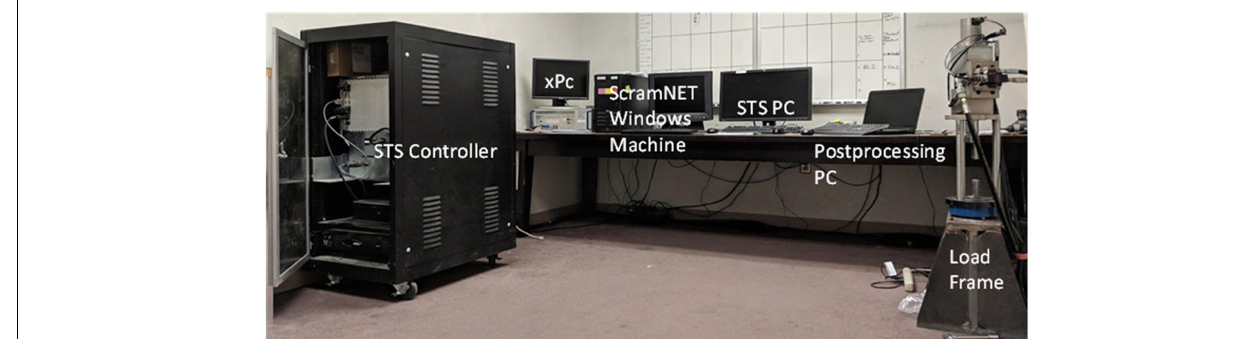
FIGURE 1 | Compact HS/RTHS test setup at UNR.